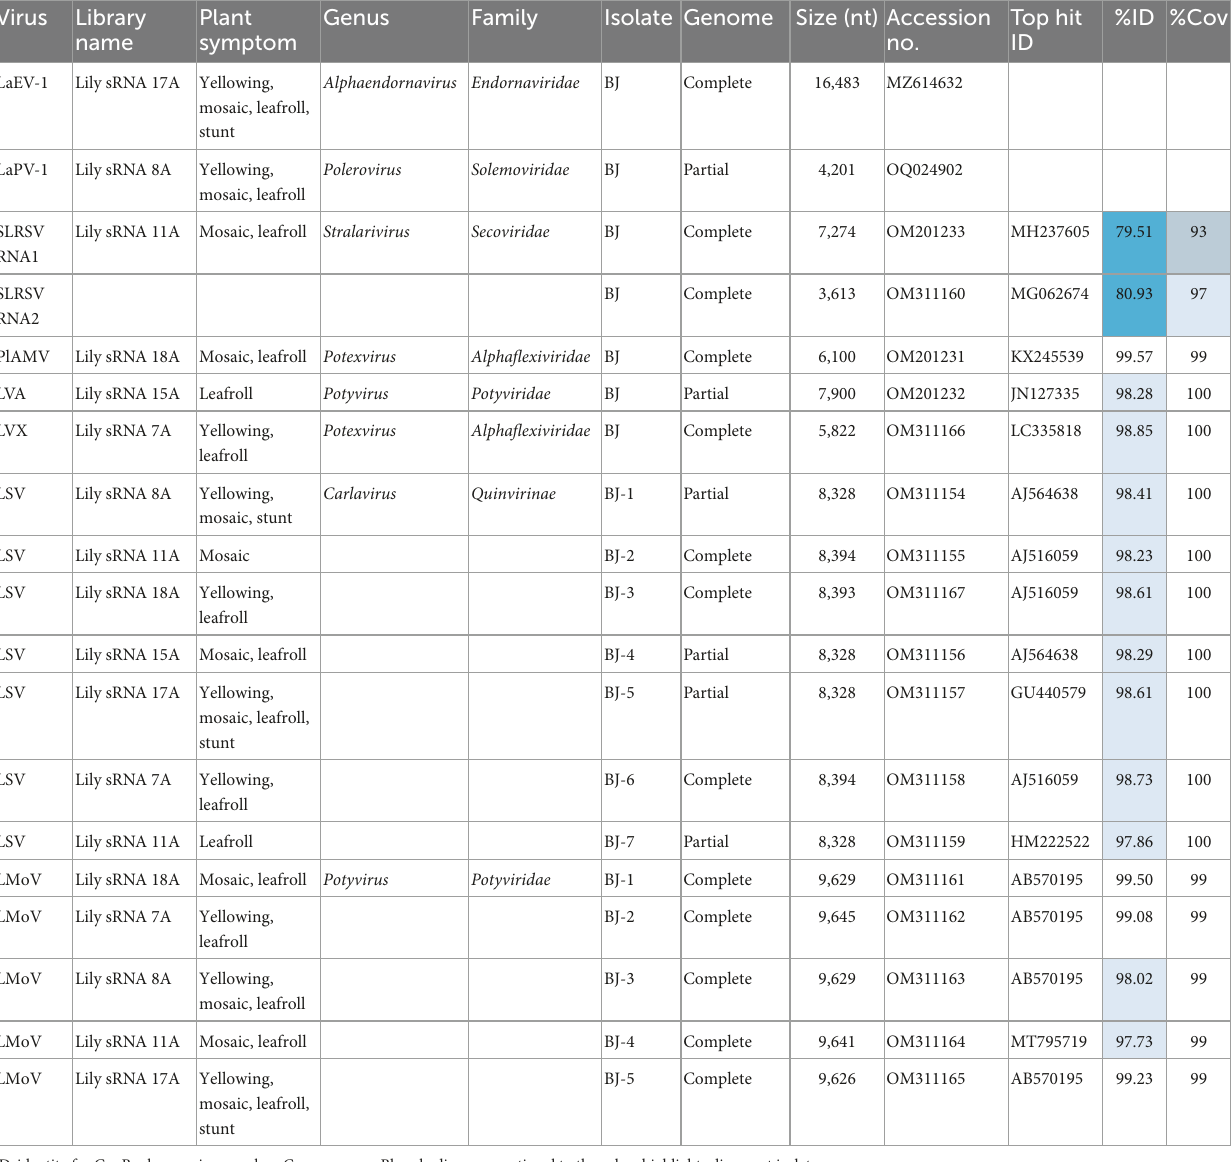
TABLE 2 The information of assembled genomes of lily-infecting viruses.